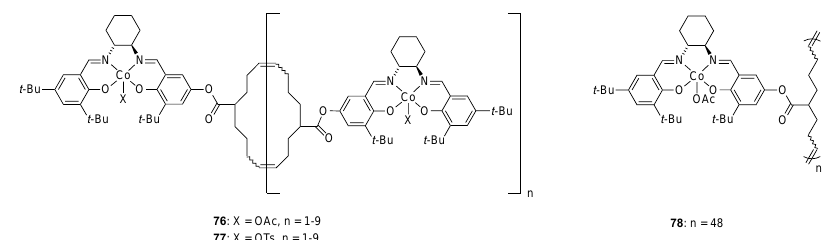
Figure 31. Macrocyclic oligosalen catalysts 76 and 77 , and linear polymeric analogue 78 .